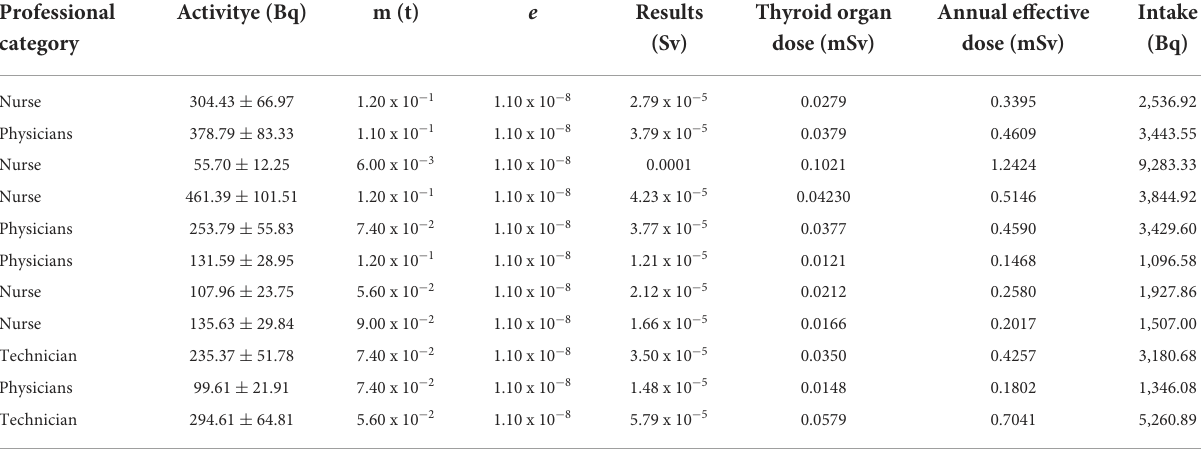
TABLE 5 Estimate of internal thyroid 131 I dose in 2020.